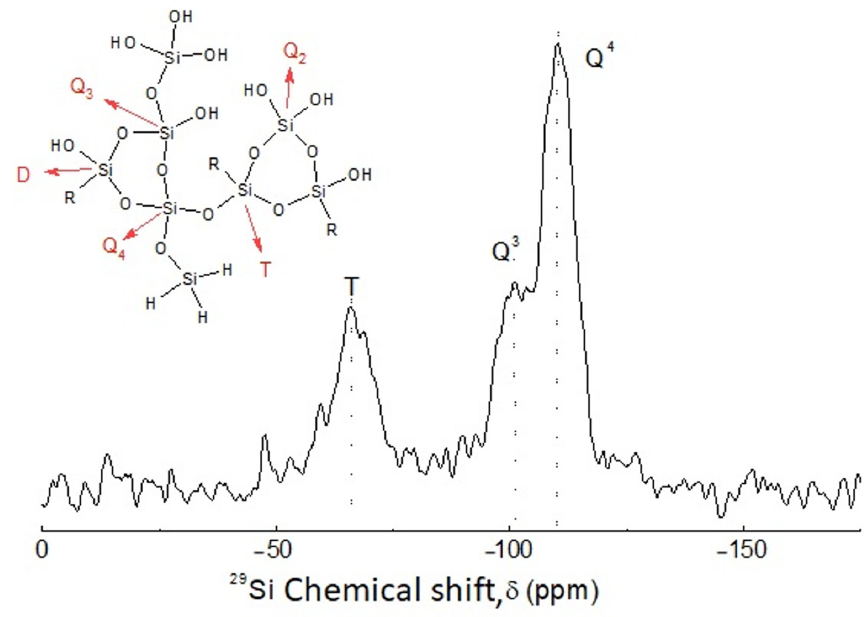
Figure 5. 29 Si-NMR spectrum of the modified material Figure 5. 29 Si ‐ NMR spectrum of the modified material Si ‐ Cl. In the 29 Si ‐ NMR spectrum of Figure 5, it is possible to observe Q 4 ‐ type resonances corresponding to SiO 4 species (53%), Q 3 ‐ type resonances of (SiO) 3 SiOH groups (21%) and T 3 ‐ type resonances associated to (SiO) 3 SiR groups [21], which may also include not ‐ well resolved T 2 ‐ type resonances of (SiO) 2 SiR(OH) groups [21]. Both materials Si ‐ Cl and Si ‐ Pu underwent a 13 C ‐ NMR analysis to verify coupling of the ligand (Purpald) onto the surface of the intermediate hybrid material (Si ‐ Cl). The col ‐ lected spectra can be found in Figure 6. Figure 6. 13 C ‐ NMR spectra of the materials Si ‐ Cl and Si ‐ Pu. Based on the collected spectra, it was possible to confirm the formation of the mate ‐ rial organofunctionalized with the silylant agent, since the chemical shift at 9.8 ppm is